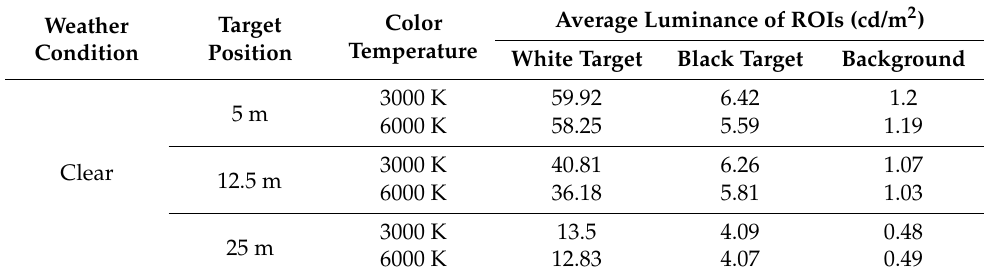
Table A1. Average luminance of ROI in clear conditions (cd/m 2 ).